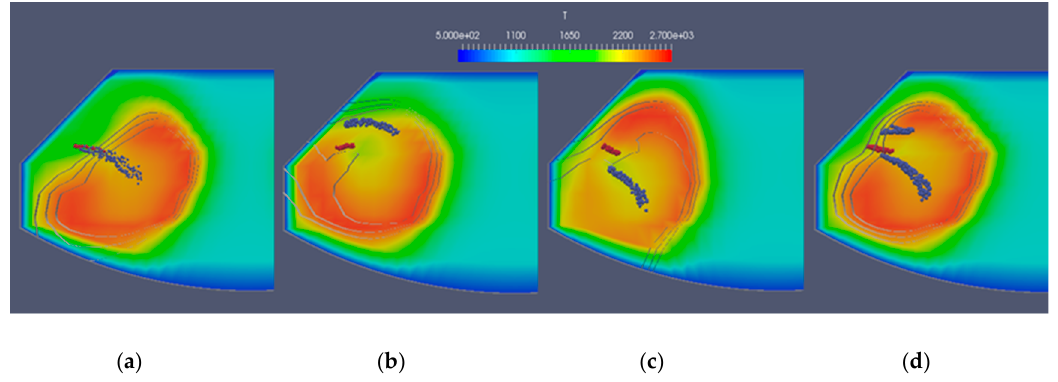
Figure 7. Temperature fields for different water injection locations, crank angle (CA) = 15 ° . ( a ) same location of the water and fuel nozzle; ( b ) water nozzle over the fuel nozzle; ( c ) water nozzle under the fuel nozzle; ( d ) case with a water nozzle over and under the fuel nozzle.